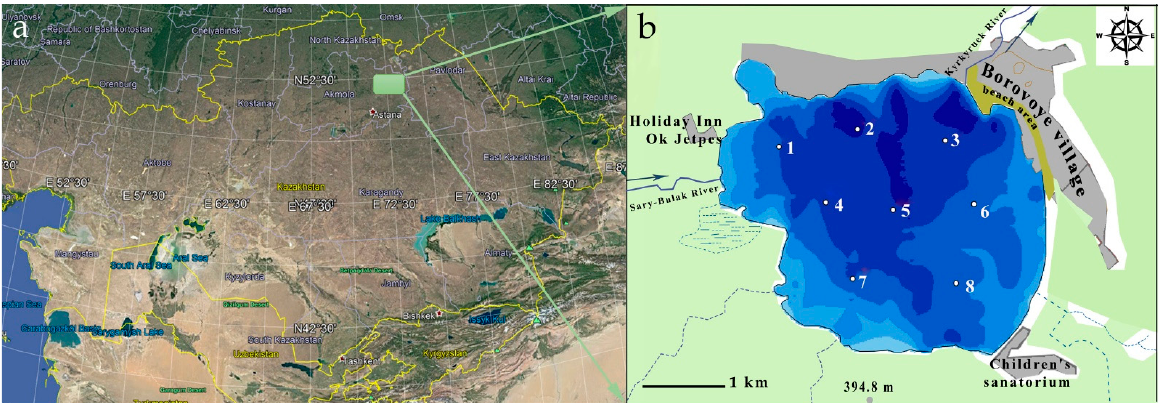
Figure 1. Map of study site on Lake Borovoe, Northern Kazakhstan, in July of 2019. Position of Lake Borovoe in Kazakhstan ( a ). Position of the phytoplankton sampling stations 1–8 on the lake surface ( b ). Map creating in ESRI ArcGIS 10.8. USA program on the base of our measurements of GIS coordinates and the lake depth on each sampling station.